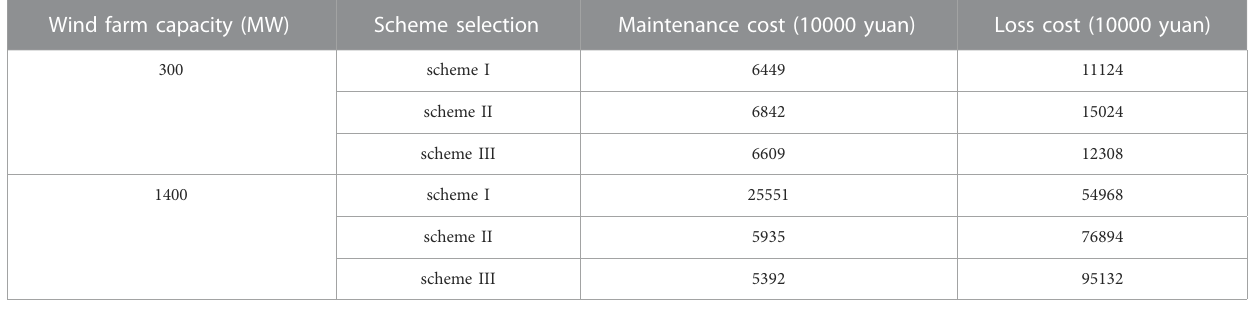
TABLE 6 Dynamic cost analysis at 80 km transmission distance at 300MW and 1400 MW